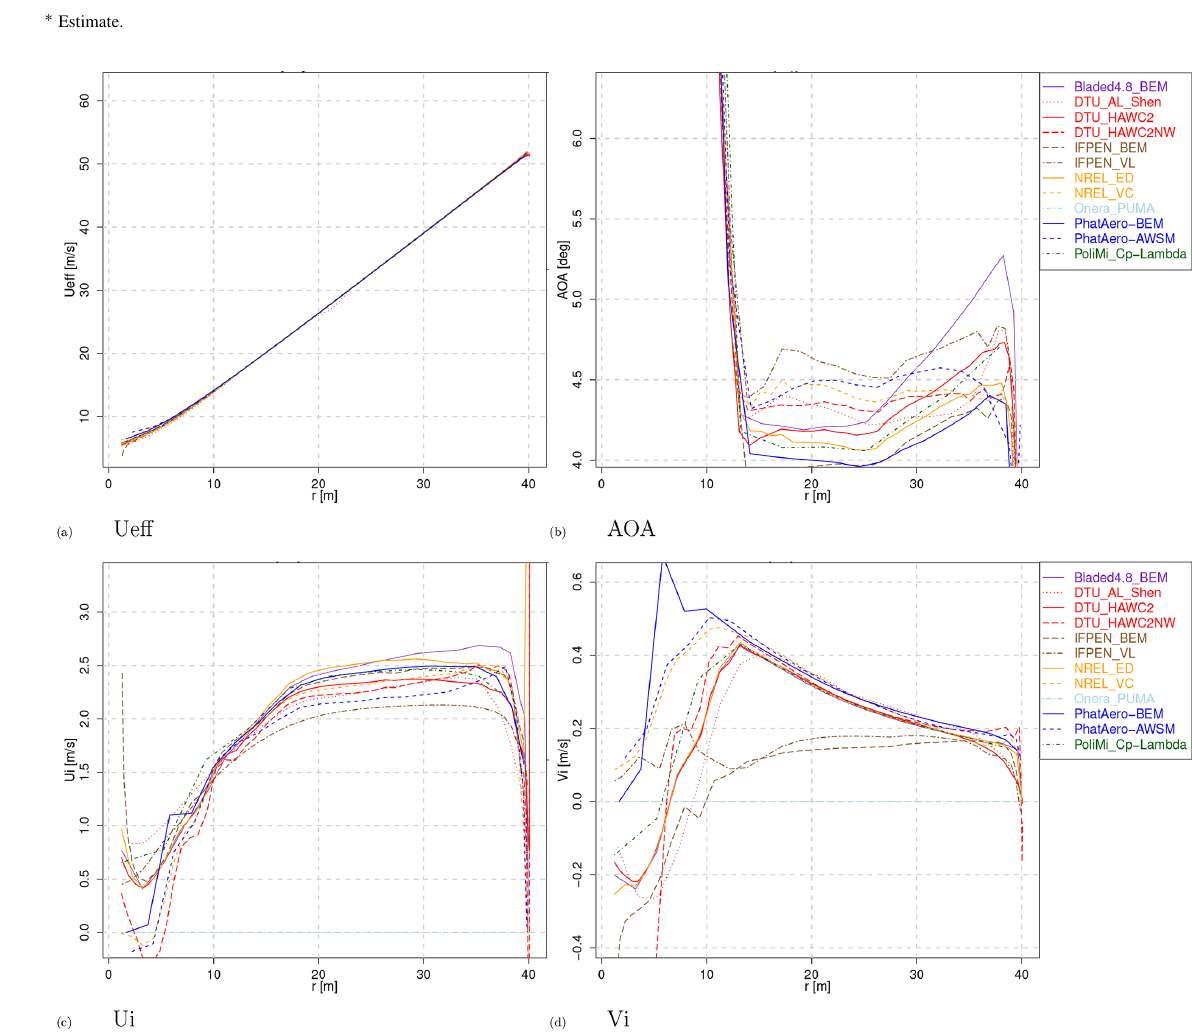
Figure 2. Lifting-line variables for Case IV.1.2.